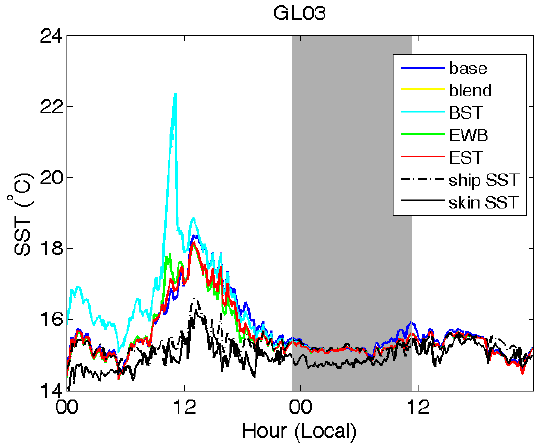
Fig. 2. Time-series of the five model simulations for the GL03 pe- Fig. 2 : Time-series of the five model simulations for the GL03 period plotted with observed riod plotted with observed skin and ship SST measurements. The skin and ship SST measurements. The grey vertical column represents the GL03 deployment grey vertical column represents the GL03 deployment period for period for SkinDeEP.